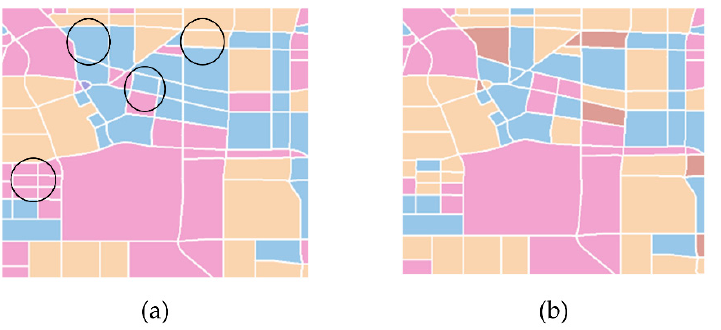
Figure 17. Comparison of the identification result of the central area between the proposed method ( a ) and the actual function categories ( b ).